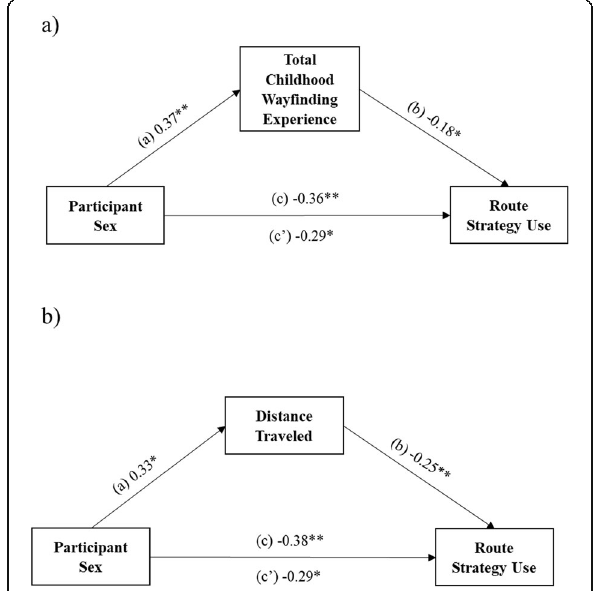
Fig. 4 Direct and indirect effects of participant sex on route strategy use through the mediators total childhood wayfinding experience ( a ) and distance traveled during childhood ( b ). * p < .05, ** p < .01, *** p < .001